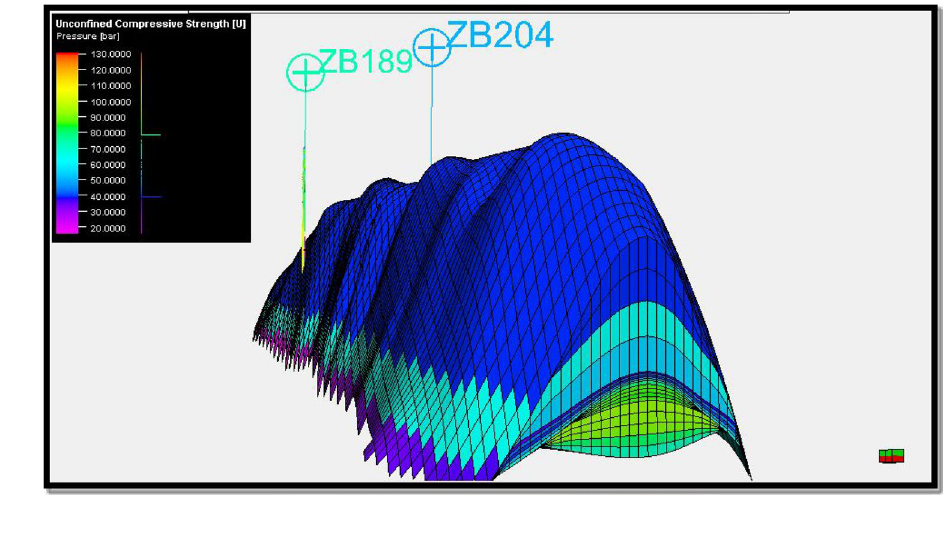
Fig. 18 Unconfined compres- sive strength